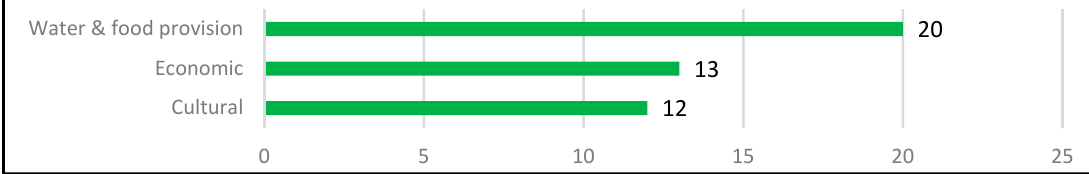
Figure 5. References to ES-related social benefits in the Chingaza case study (own representation).